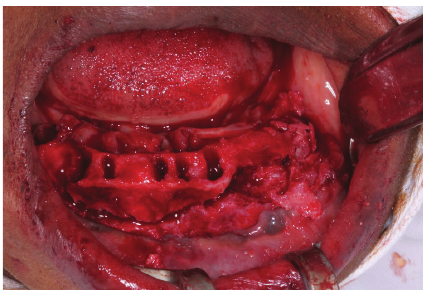
Figure 7: Histopathologic appearance of the ossifying fibroma showing fibroblastic stroma with small calcifications (hematoxylin- eosin, 10x).